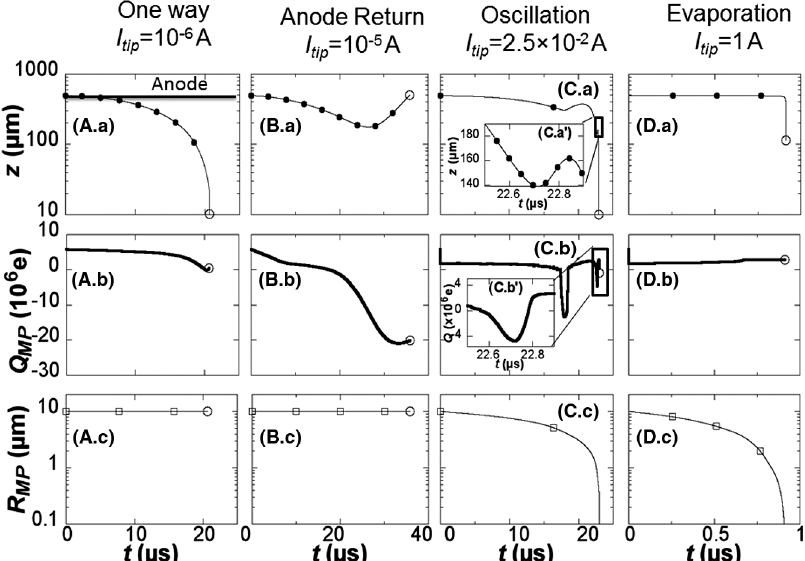
FIG. 11. Dynamics regimes of a test MP for different emission currents. The rows represent the time evolution of: (a) the flight distance (z) from anode ( 500 μ m) towards the cathode (z ¼ 0 ); (b) the charge (× 10 6 e) of the MP; and (c) the MP radius ( R columns, the first corresponds to “ one way ” trajectory from the anode to the cathode and low tip current. The second column corresponds to a MP back-attracted to the anode. The third column corresponds to an oscillating MP before reaching the tip. The fourth column represents an MP finishing fully evaporated due to the very high primary current. For each current, V d ¼ 0 . 5 mm have been kept fixed as well as the initial particle radius. Animations for each regime are available on-line [58].